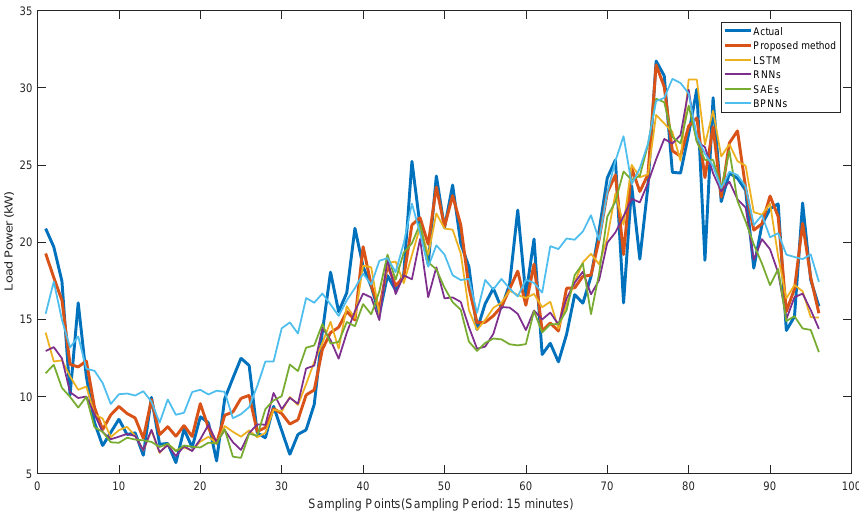
Sampling Points(Sampling Period: 15 minutes) Figure 16. The load curves of Customer 37148000 based on the proposed method and the other current